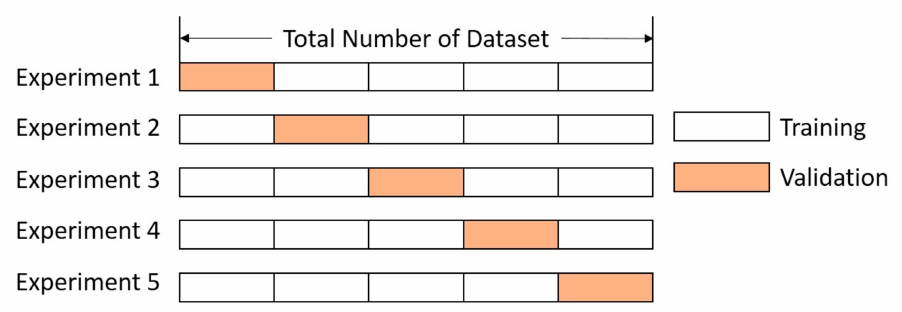
Figure 3. k-fold Cross-validation.